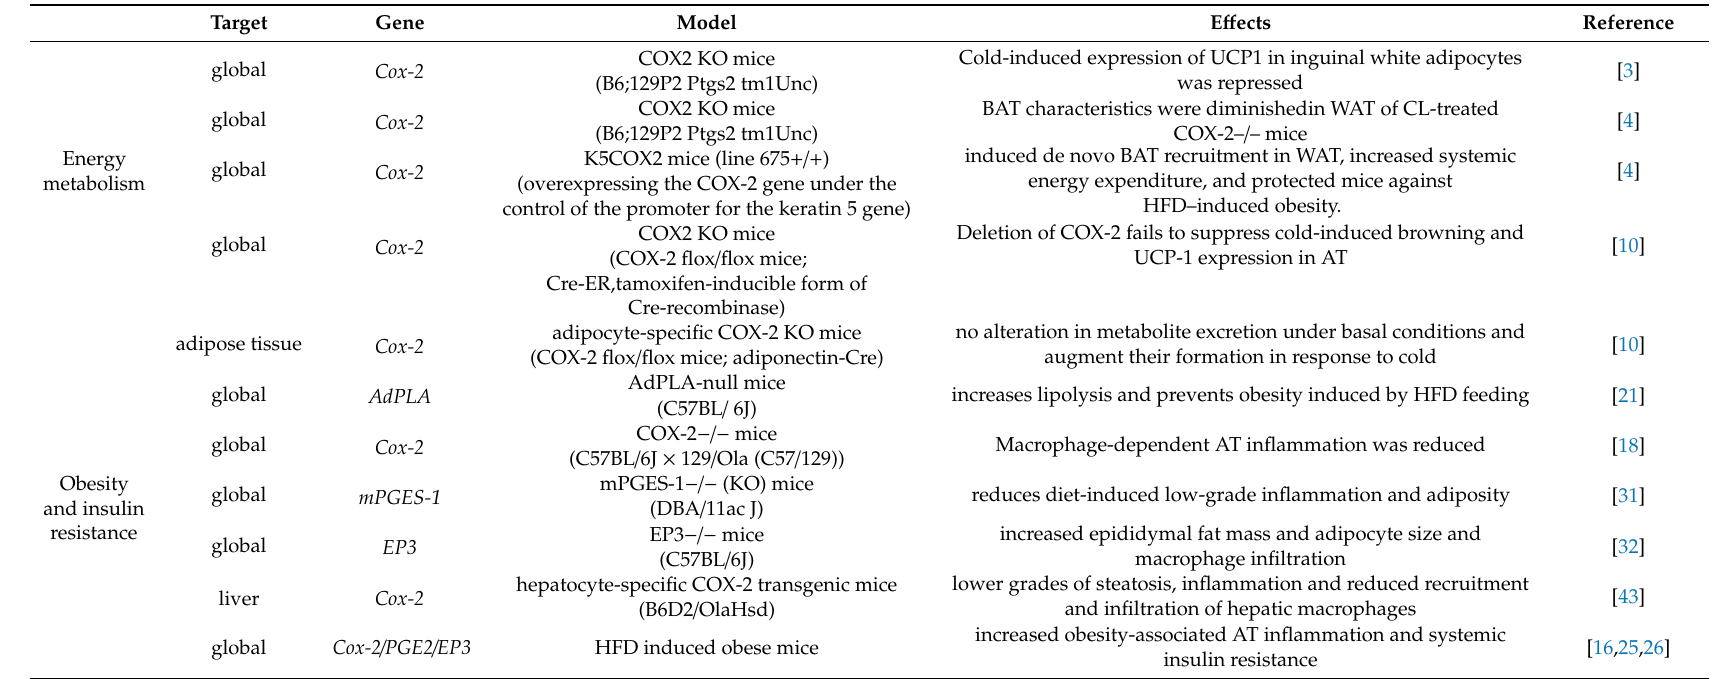
Table 1. Overview of animal studies targeting COX-2 -mediated signaling